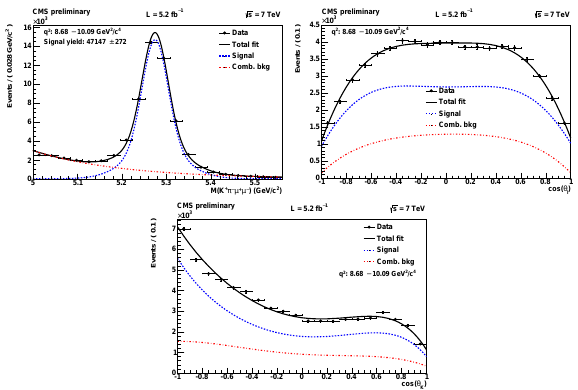
Figure 3. The K + π − µ + µ − invariant mass (top left), cos θ L (top right), and cos θ K (bottom) distributions for the q 2 bin associated to the B 0 → K ∗ 0 J /ψ , along with the projections of the fit.